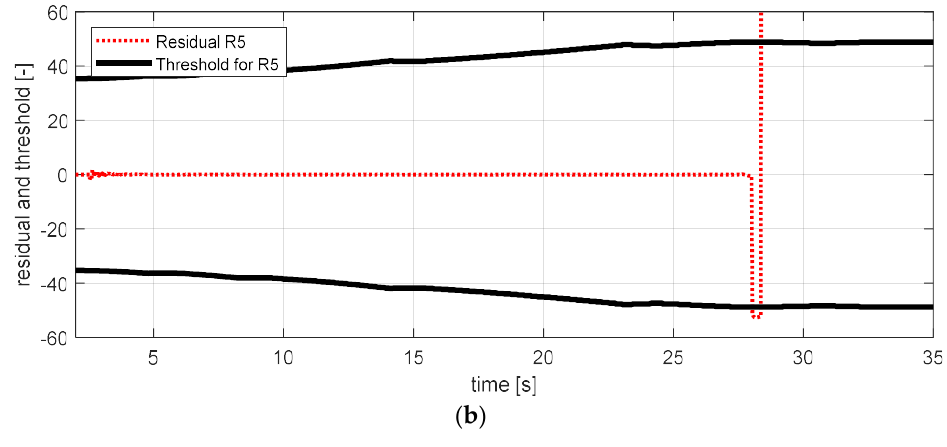
Figure 24. FDI simulation result for wheel angular speed sensor—fr (fault). ( a ) Residual 2 and threshold; ( b ) residual 5 and threshold.